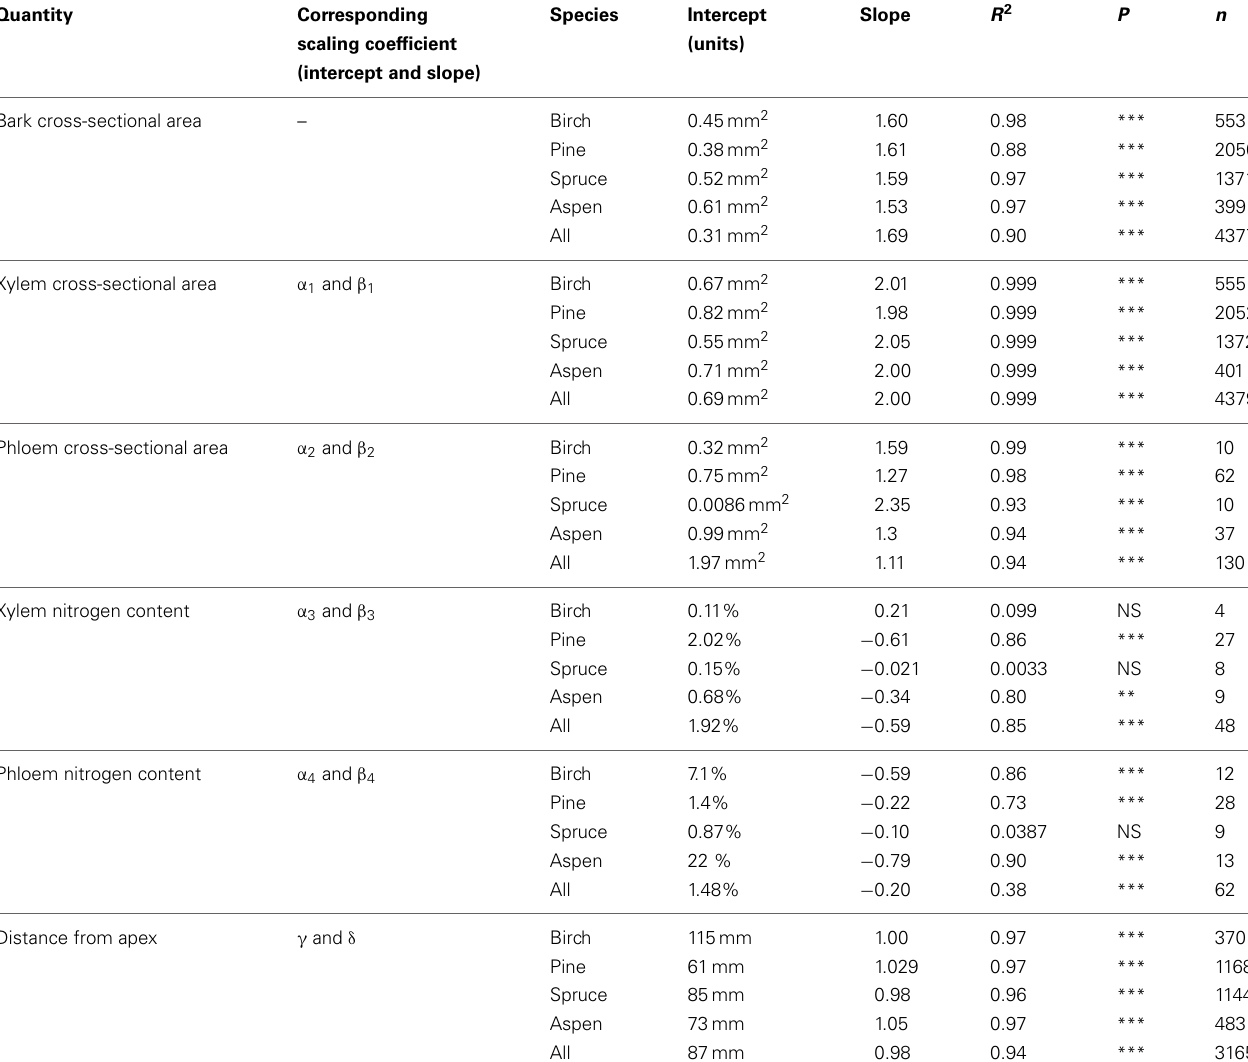
Table 2 | Measured properties as a function of stem/branch diameter for each species from the measurements: P = B ∗ d E , where P is the property under consideration, B is the base, and E is the